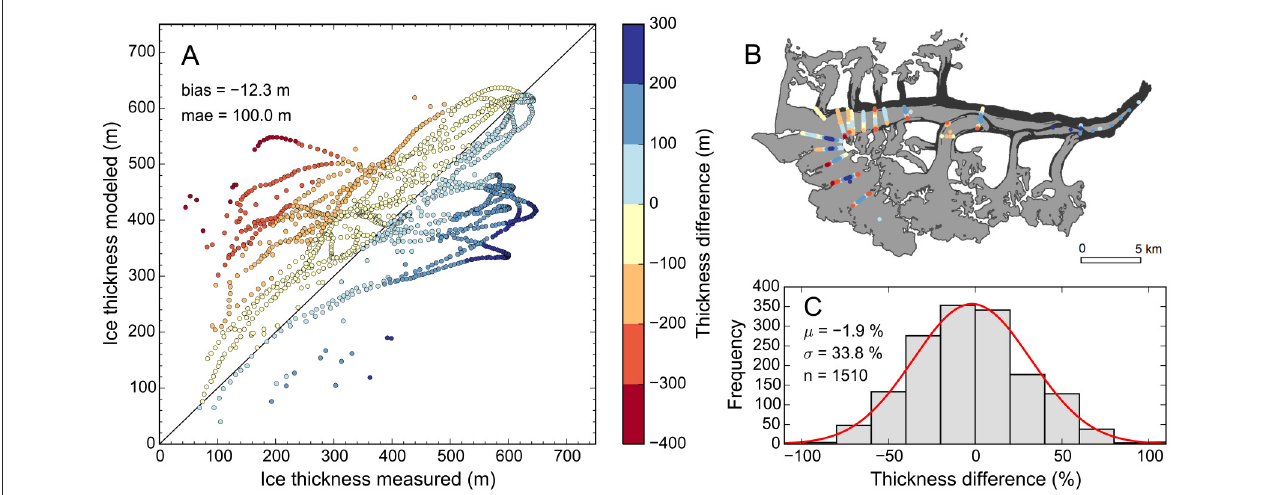
FIGURE 2 | (A) Modeled vs. measured ice thickness with colors showing the thickness difference (measured—modeled). Blue shades (positive thickness differences) indicate that the modeled bed is too shallow. The measured thicknesses are adjusted for the 2010 surface. The map in (B) shows the thickness differences at their actual locations on the glacier, using the same colors as (A) . (C) Frequency distribution of thickness differences (in percent of the modeled ice thickness), with the red line showing the Gaussian